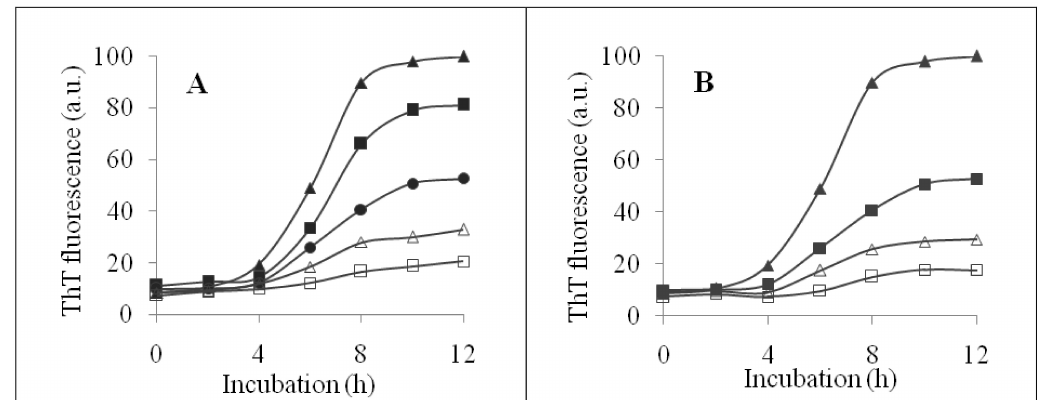
Figure 2. ThT assay to monitor the kinetics of insulin fibrillation in the absence and presence of AsA and its degradation products. ( A ) Dose-dependent inhibitory effects of AsA on insulin fibrillation. Filled triangles, insulin only; filled squares to open squares, insulin incubated with 0.2, 0.4, 0.6, and 0.8 mM AsA, respectively. ( B ) The kinetics of insulin fibrillation in the presence of AsA degradation products. Filled triangles, insulin only; filled squares to open squares, insulin incubated with 0.4 mM AsA degradation products obtained by pre-incubation with AsA for 0, 24, and 48 h, respectively. All data were normalized to the maximum ThT